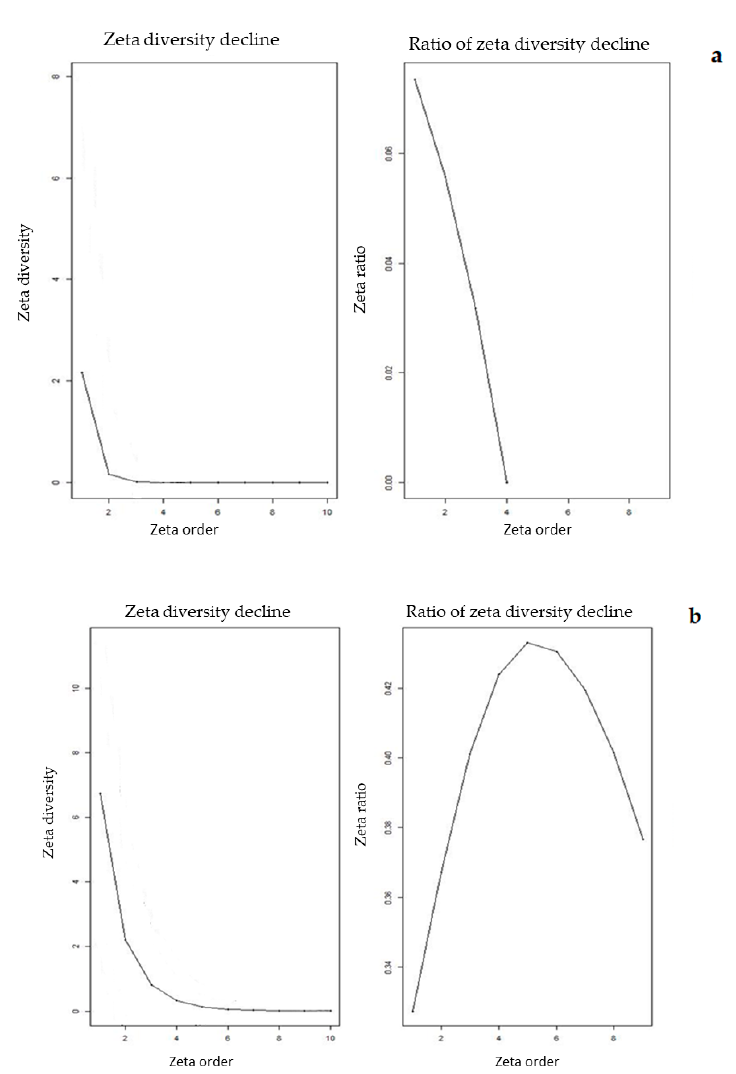
Figure 11. The zeta diversity decline and ratio of zeta diversity decline for ( a ) obligate (OCh) and ( b ) endemic obligate (EN) chasmophytes.